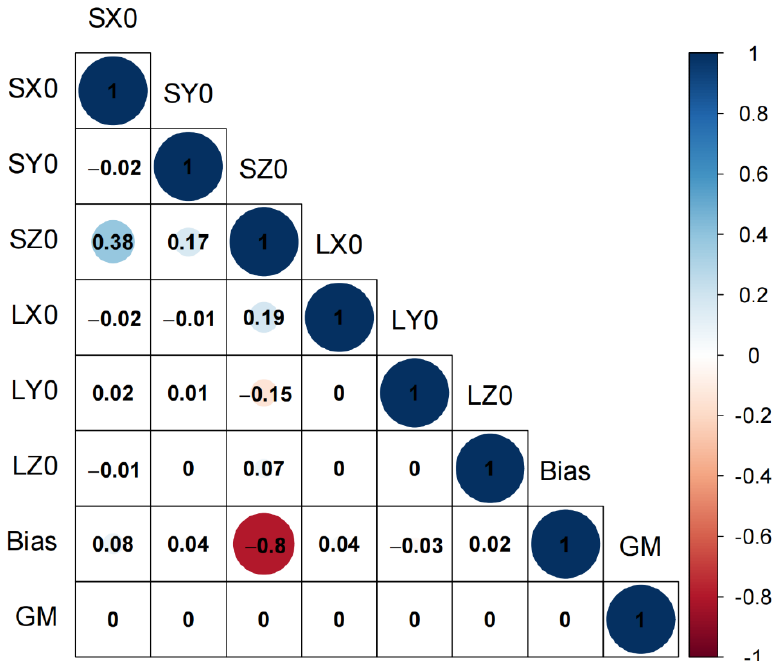
Figure 4. Normalized correlation matrix of the solve-for parameters corresponding to the values of Table 7. The correlations relative to the Rosetta S/C position [SX0, SY0, SZ0] are given in the J2000 comet-centered system of reference. An important result is that GM is uncorrelated with the other parameters, showing that CONSERT-like measurements can be, in principle, used to determine the GM coefficient, if sufficient numbers of measurements are stacked along an orbit with no maneuvers. We also see that the CONSERT instrument bias has a strong correlation with the SZ0 value (see text).